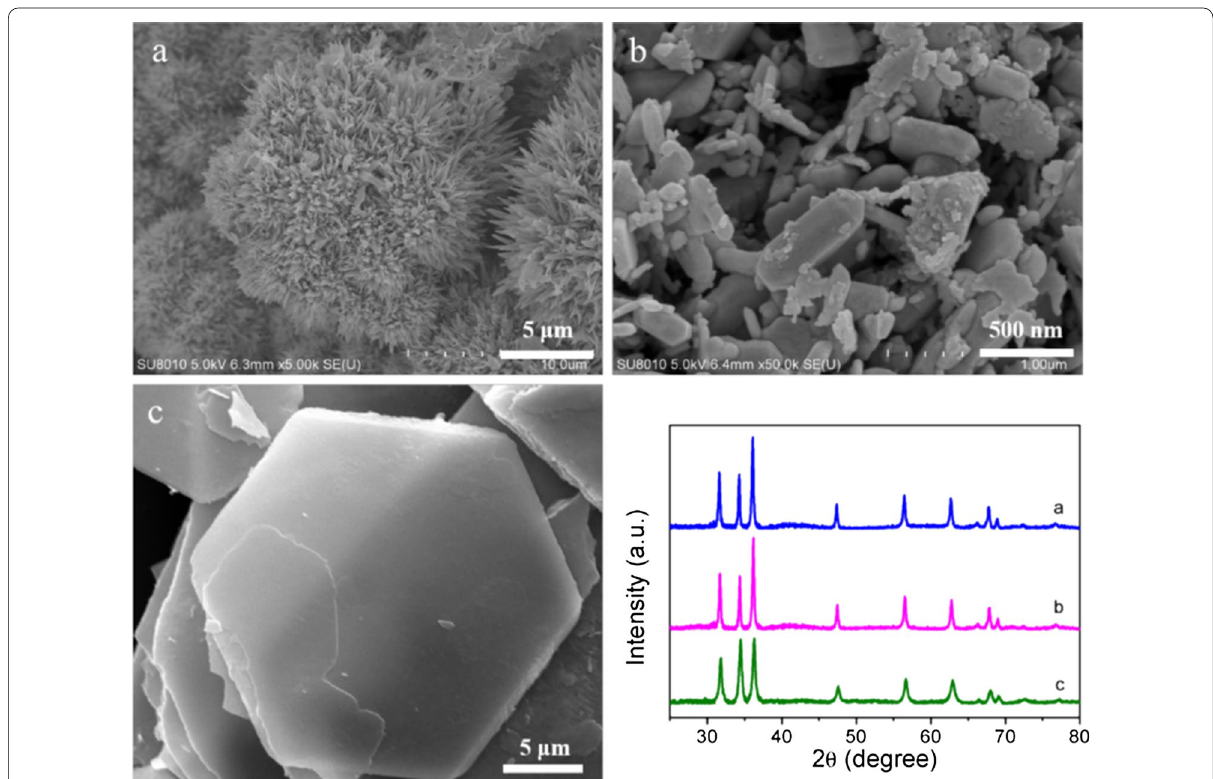
Fig. 2 Morphological and structural analysis of other ZnO nanostructures obtained by using zinc nitrate, zinc sulfate, and zinc chlorion as precursor. SEM images of a ZnO nanoflowers, b nanoflakes, c hexagonal nanoplates, and d their corresponding XRD